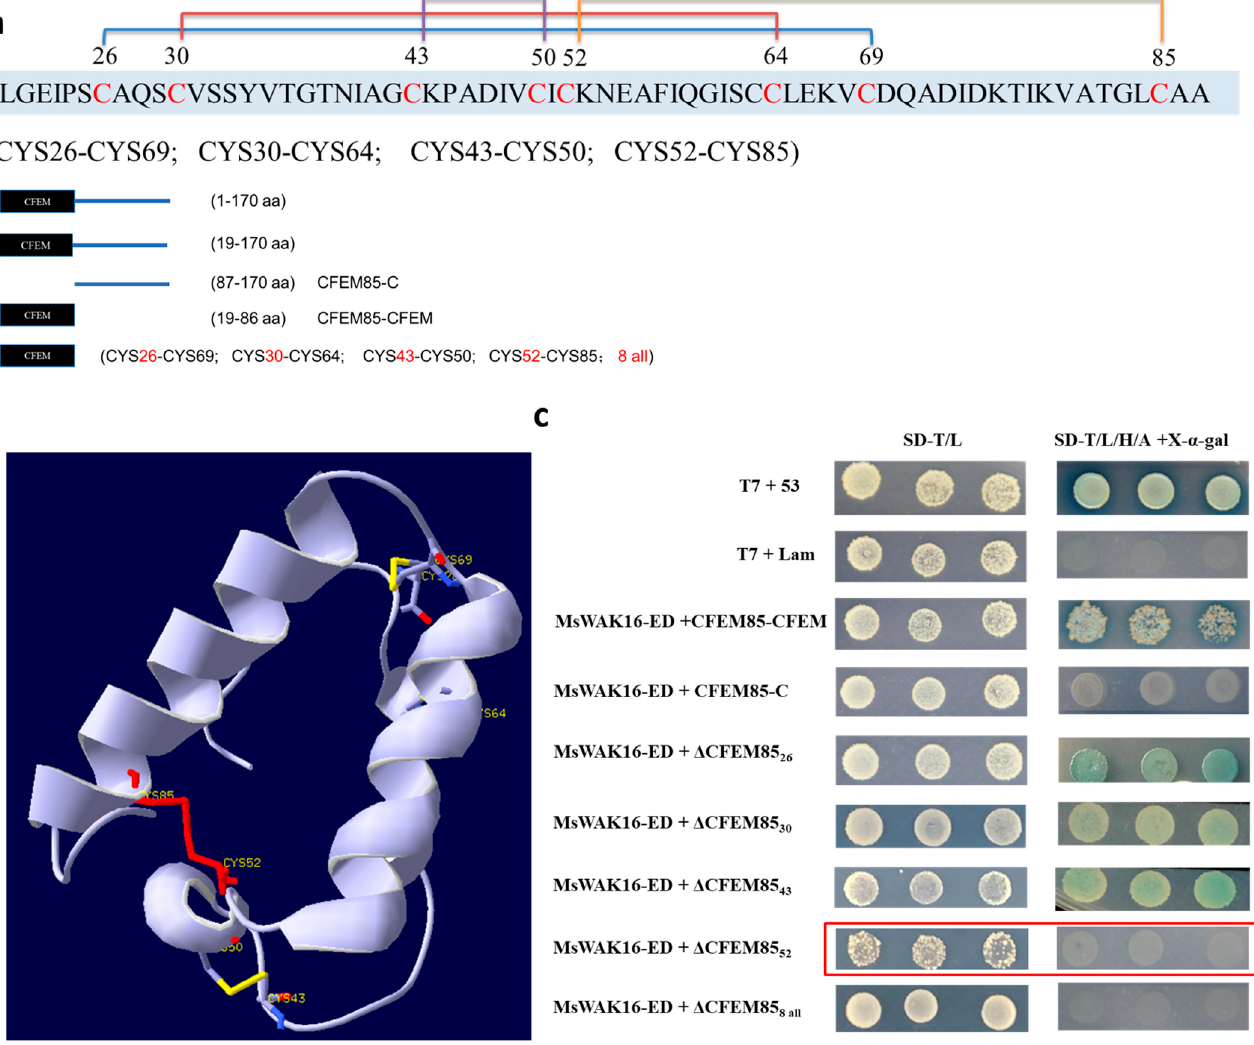
Figure 3. Identification of the interaction site between MaCFEM5 and MsWAK16. ( a ) Schematic illustrations of MaCFEM85. Protein domains in MaCFEM85 were predicted and visualized using SMART (embl-heidelberg.de). ( b ) Positions of the eight cysteines in MaCFEM85 and a schematic showing the four disulfide bonds. ( c ) Truncated MaCFEM85 constructs were generated that included the CFEM domain (19–86 aa of the N-terminal, CFEM85-CFEM) and that included residues 87–170 without the CFEM domain (CFEM85-C). The other five variants were C26A( Δ CFEM85 26 ), C30A( Δ CFEM85 30 ), C43A( Δ CFEM85 43 ), C52A( Δ CFEM85 52 ), and C26/30/43/50/52/64/69/85A ( Δ CFEM85 8 all ). Each construct was co-transformed in yeast with MsWAK16-ED and grown on either the two-deficiency medium SD-T/L (SD-Trp/Leu) or the four-deficiency medium SD-T/L/H/A + X- α -gal (SD-Trp/Leu/His/Ade + X- α